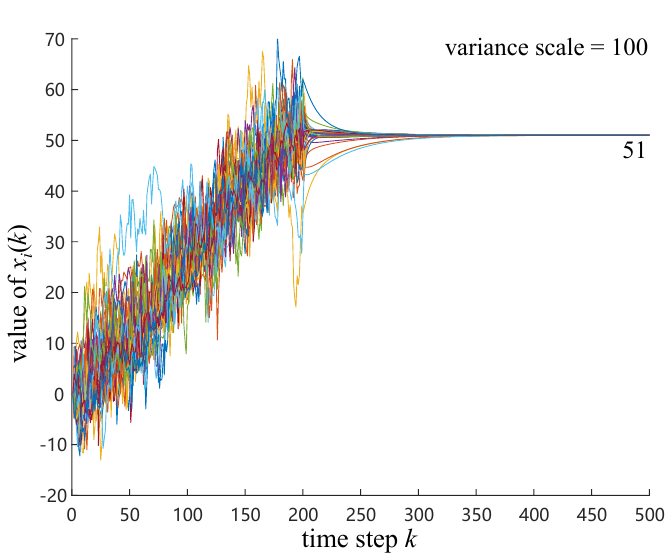
Figure 21. State-split method under large variance.